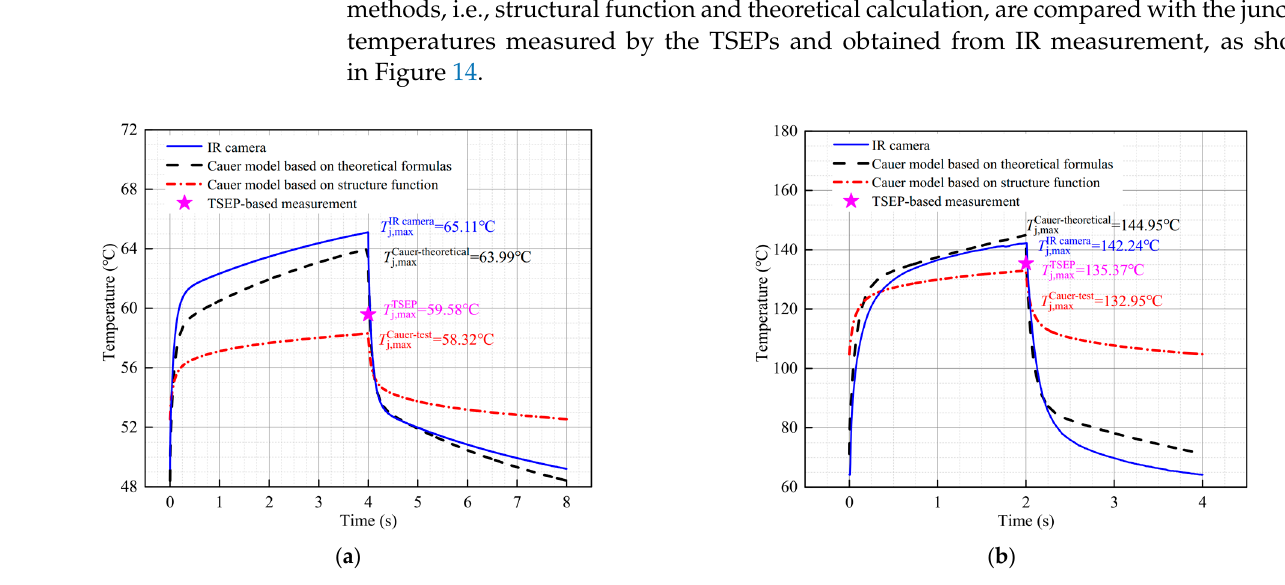
Figure 14. Comparison of the temperatures from the IR camera measurement and the Cauer model analysis for the central region of the IGBT chip: ( a ) Under DC-1 test conditions; ( b ) Under DC-2 test conditions.